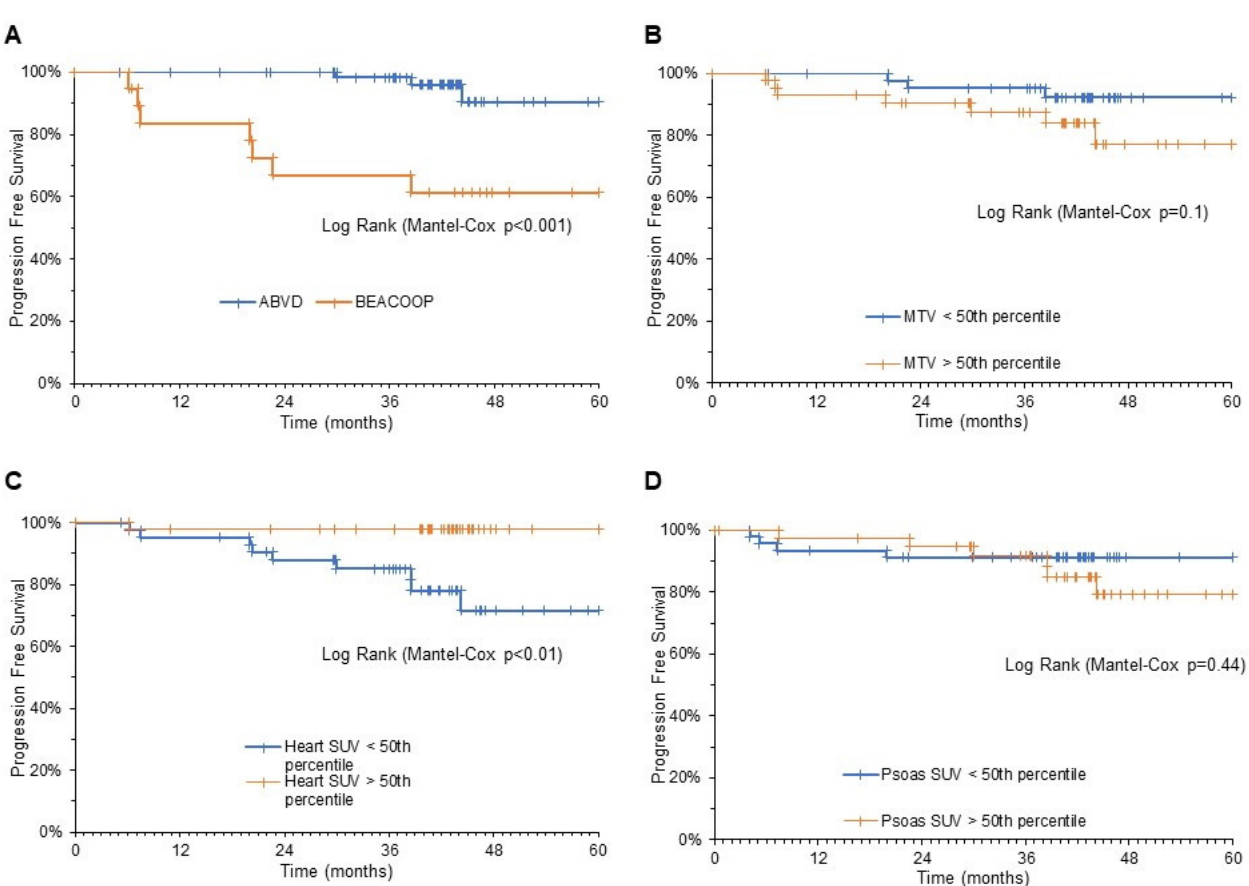
Figure 4. Kaplan–Meier analysis of PFS. Event-free survival was predicted by the need of therapy escalation according to DSS ( A ) and cardiac SUV at interim PET ( C ). By contrast, disease bulk evaluated by MTV ( B ) and skeletal muscle SUV ( D ) were devoid of this predictive power.